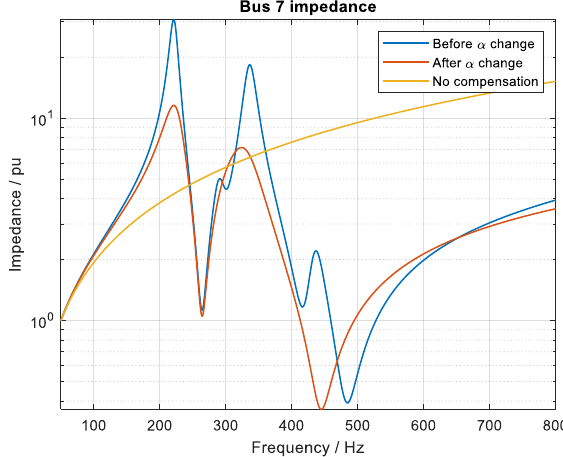
Figure 9. Bus 7 impedance change.